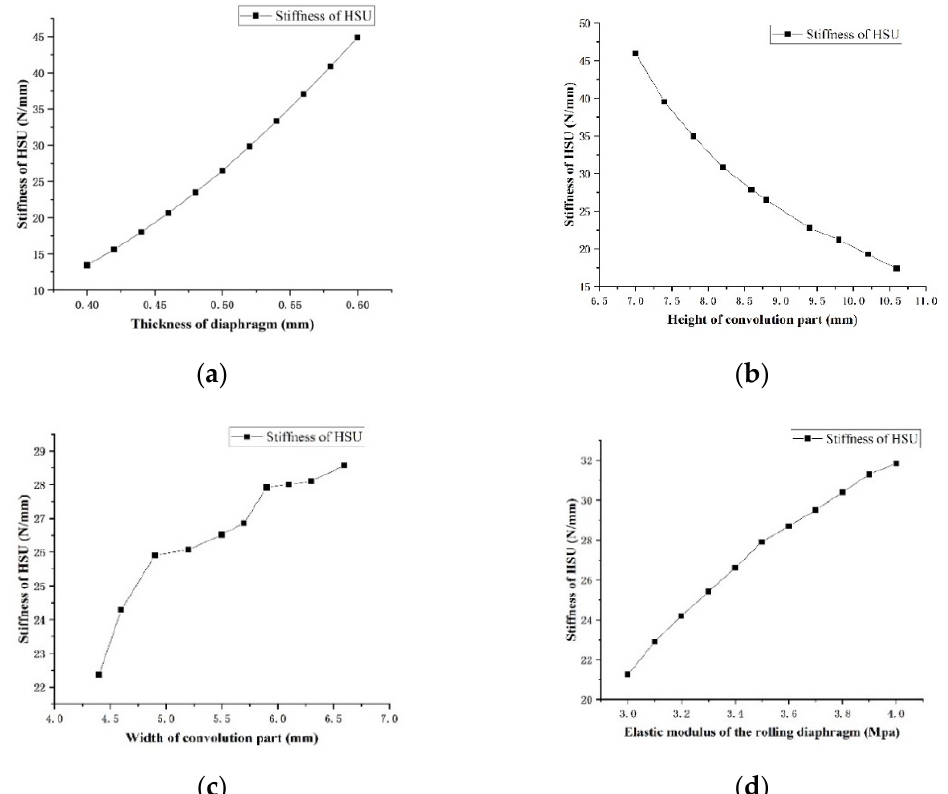
Figure 7. ( a ) Effect of the rolling diaphragm thickness on support stiffness; ( b ) effect of the rolling diaphragm convolution height on support stiffness; ( c ) effect of the rolling diaphragm convolution width on support stiffness; ( d ) effect of elastic modulus on support stiffness.